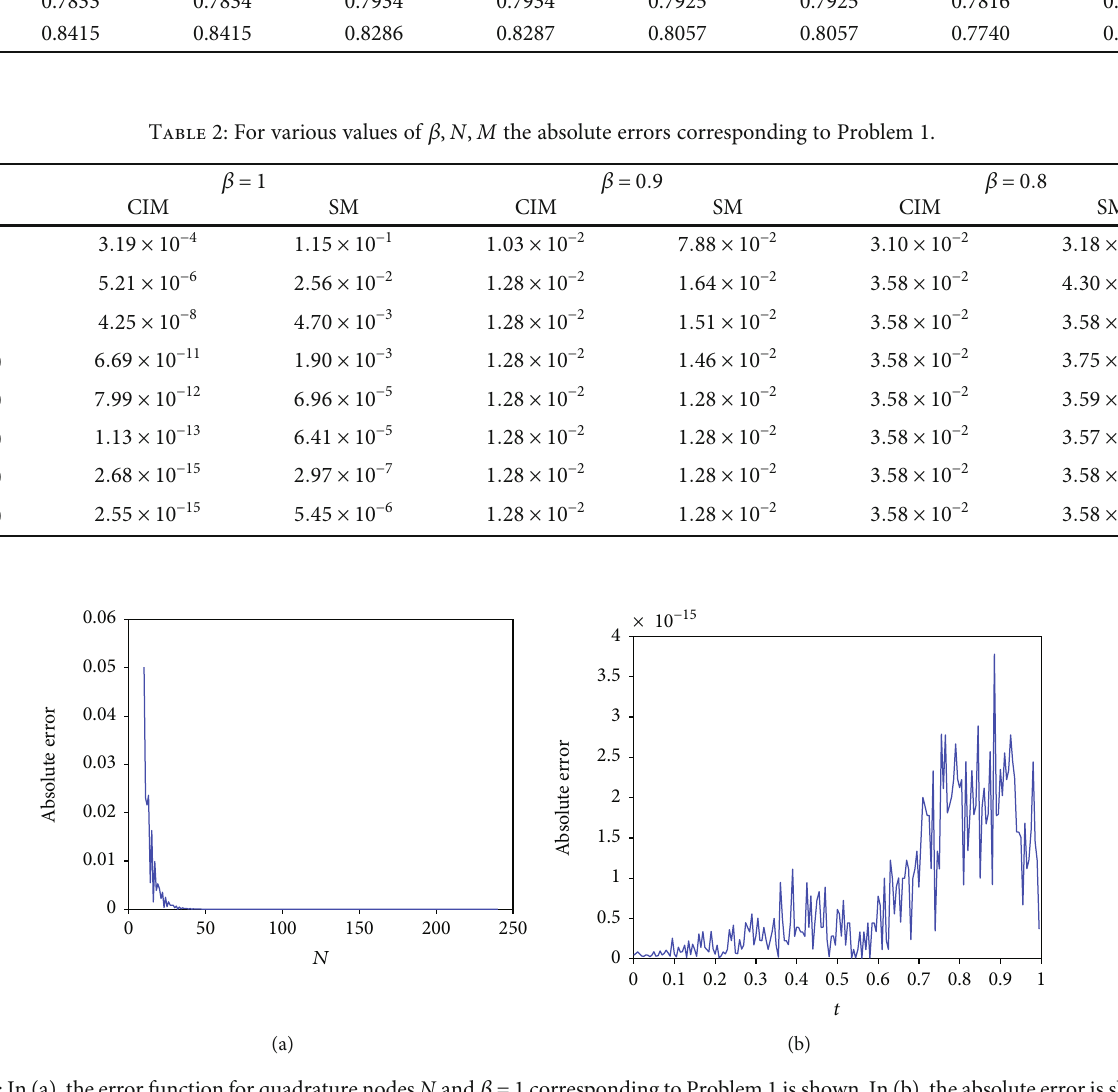
Figure 1: In (a), the error function for quadrature nodes N and β = 1 corresponding to Problem 1 is shown. In (b), the absolute error is shown for β = 1 ; a very high accuracy is